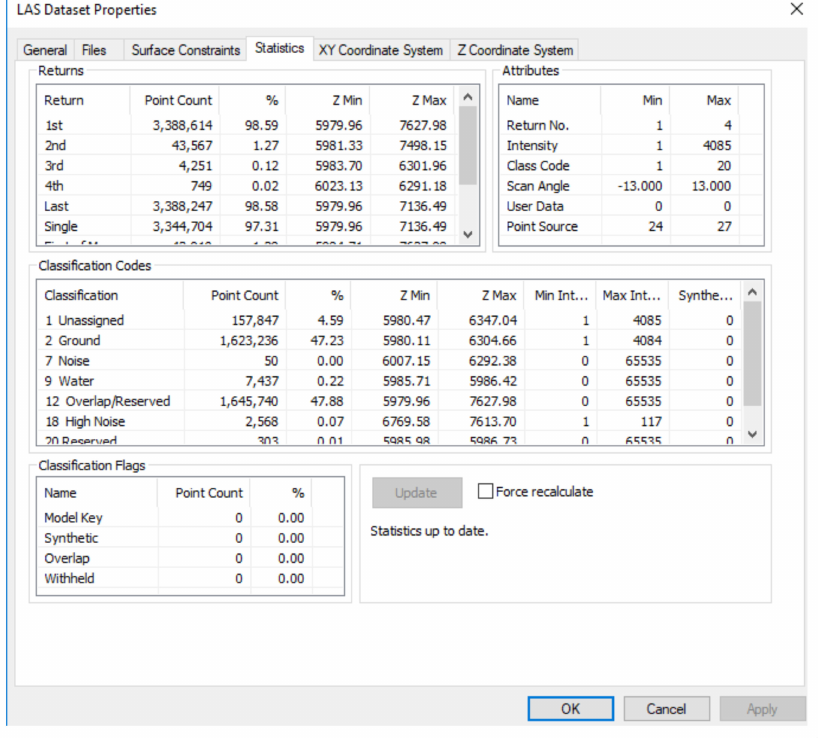
Figure 2. Classified aerial lidar